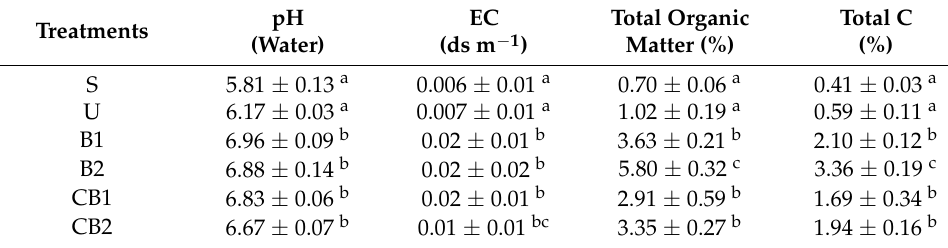
Mean values within column with different letter(s) indicate significant difference between treatments by Tukey’s test at p ≤ 0.05. Columns represent the mean values ± SE. The treatments evaluated were: S: Soil only,